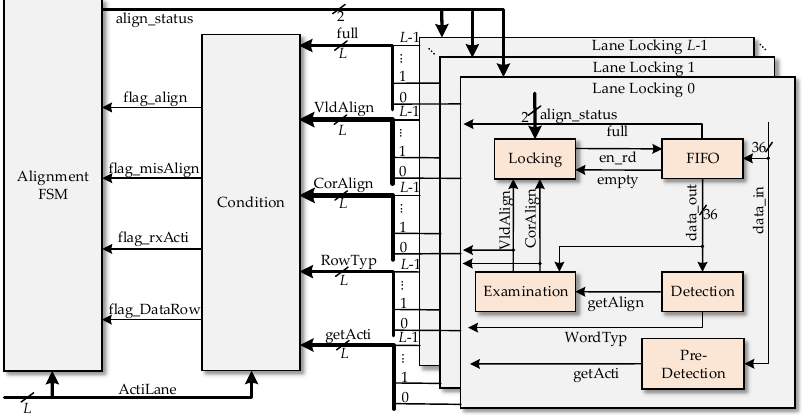
Figure 7. Architecture of the fast alignment subsystem.